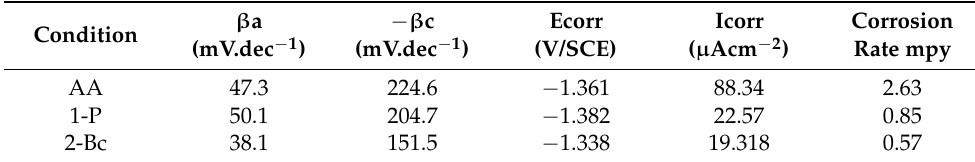
Table 1. Electrochemical parameters obtained from potentiodynamic polarization curves of as- annealed condition (AA) and processed AZ31 Mg